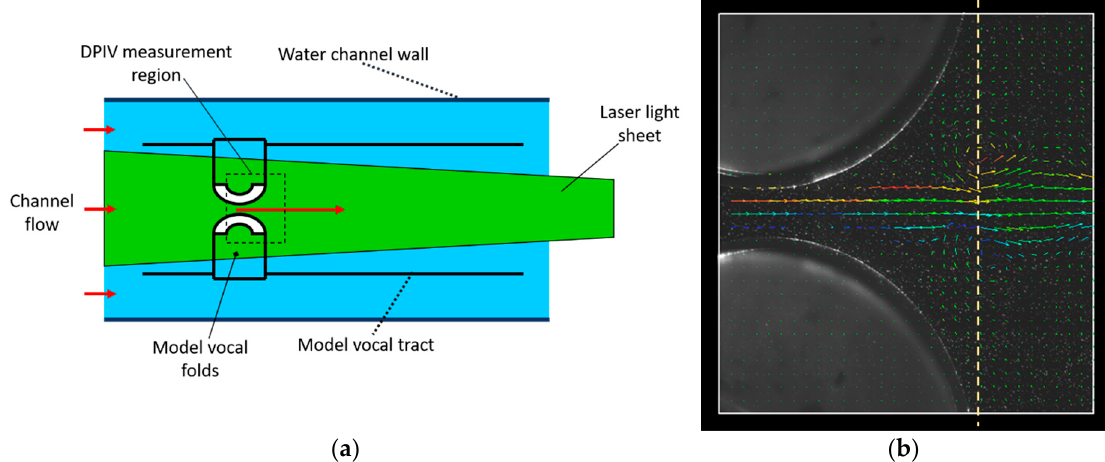
Figure 1. ( a ) Schematic of experiment [1,2] that provided measurements analyzed in this work. Vocal tract model is immersed in a water channel. Flow around channel pressurizes subglottal region, forcing flow through the vocal folds when glottis is open. Vocal folds open and close for a single cycle, during which DPIV measurements are performed in the region shown. ( b ) Still of DPIV measurements, superimposing video image and flow velocity vector field, showing passage of a glottal jet instability vortex through the glottis exit, indicated by the vertical dotted line.